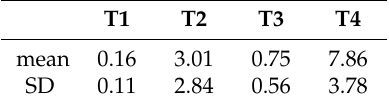
Table 5. Mean and SD of B Lymphocytes (CD20).